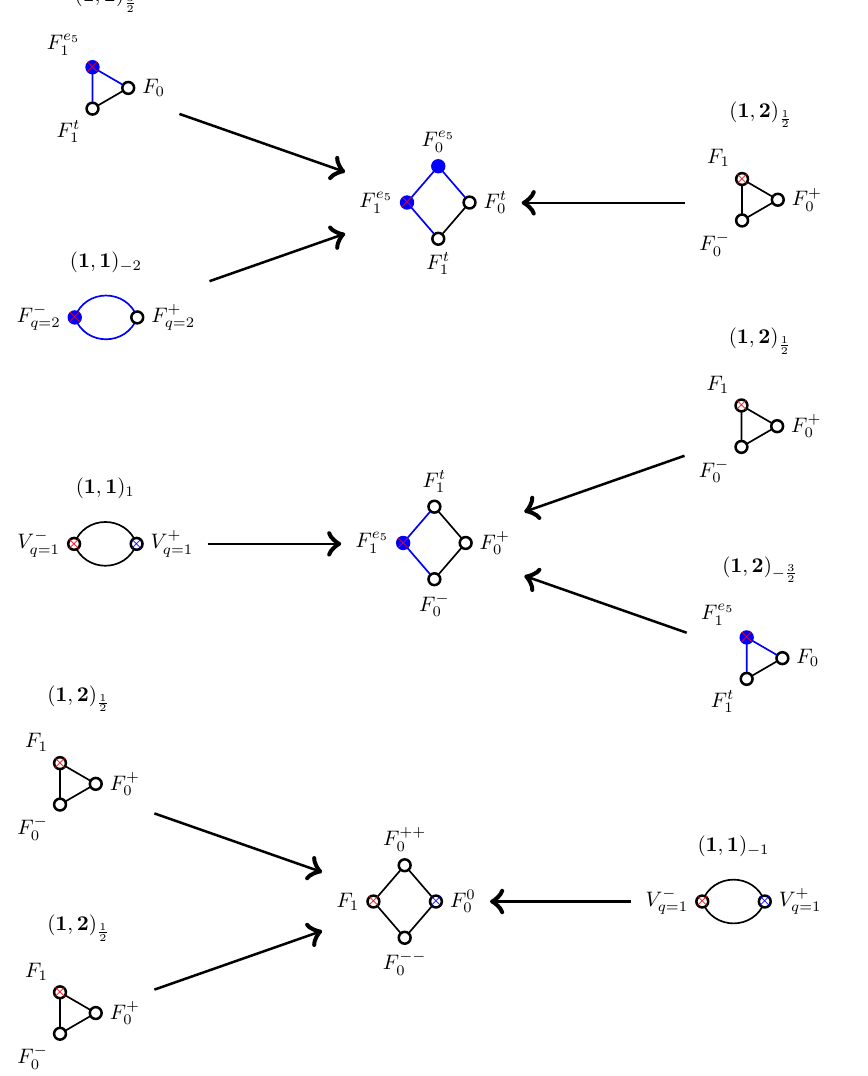
Figure 8 . Singular fibers associated to Yukawa interactions of the form ( 1 , 2 ) w